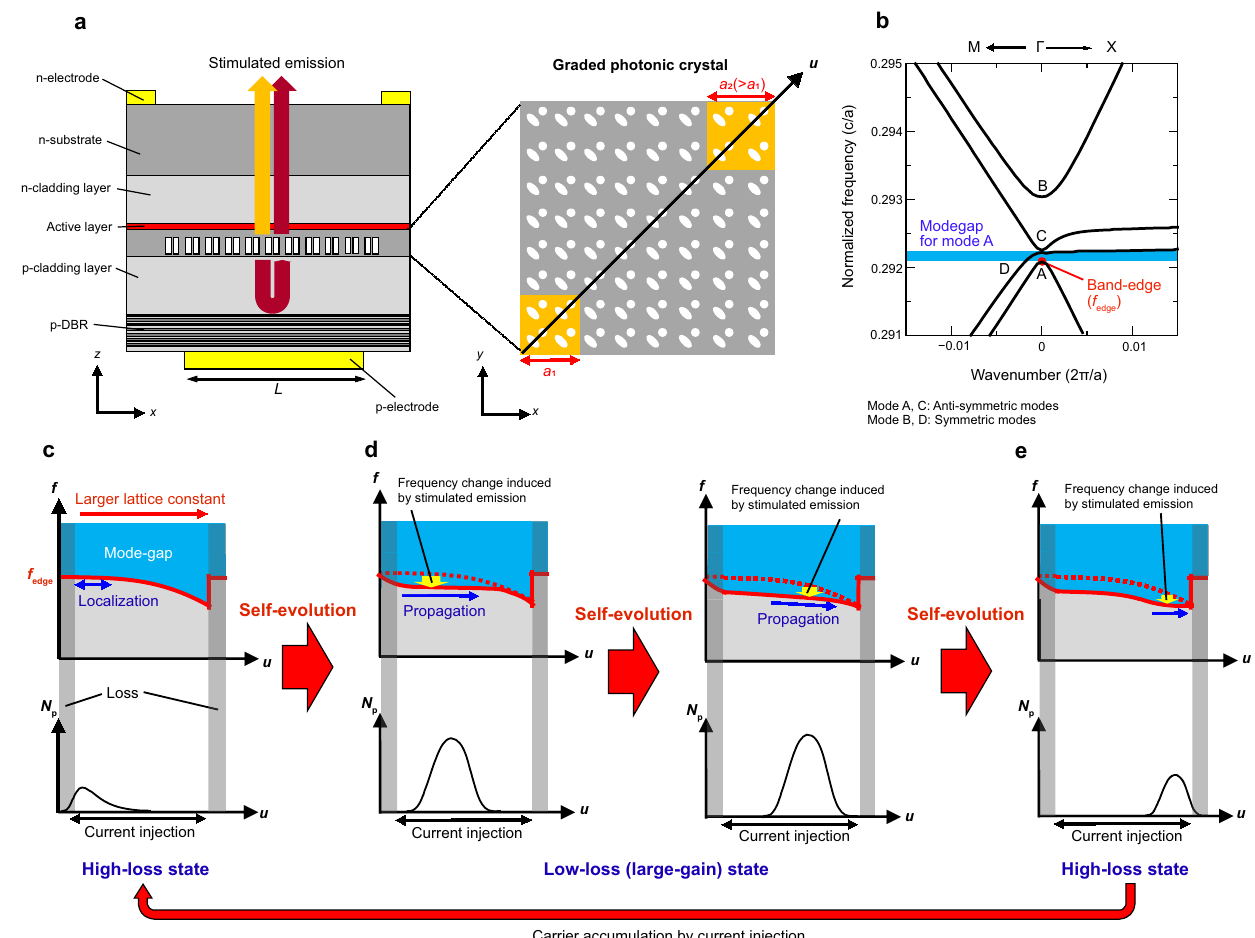
Fig. 1 | Principle of self-evolving graded photonic crystals for short-pulse generation. a Schematic picture of a photonic-crystal surface-emitting laser (PCSEL)withaself-evolvinggradedphotonic-crystal,wherethelatticeconstantofa double-lattice photonic crystal is monotonically increased inside the current injection region. b Typical photonic band diagram of a double-lattice photonic crystal. c Band-edge frequency distribution f edge (upper) and photon density dis- tribution N p (lower) insidethe self-evolving photoniccrystalbefore lasing. d Band-